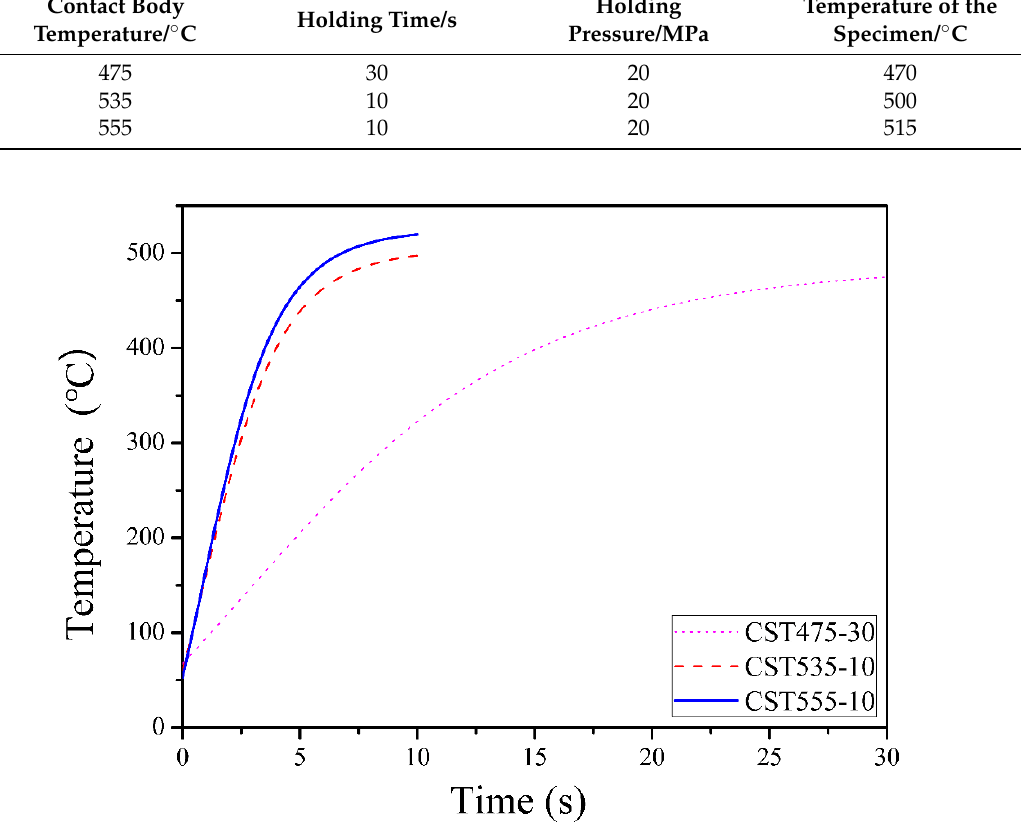
Table 1. Chemical composition of 7075 Al alloy(wt%).